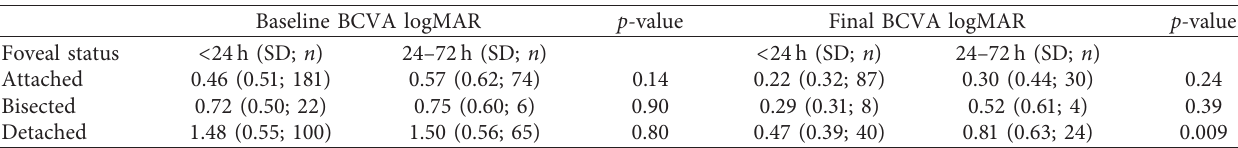
BCVA, best-corrected visual acuity; h, hours; logMAR, logarithm of minimum angle of resolution; n , number of patients; SD, standard deviation.